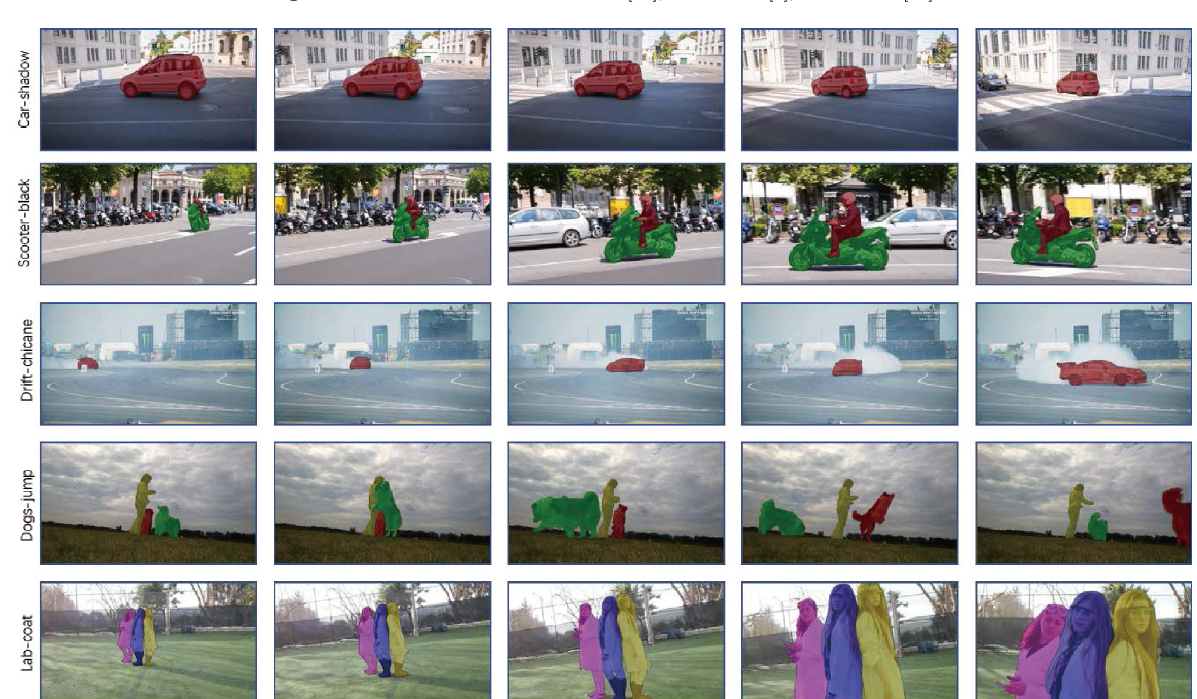
Fig. 9 Further results from our method using the DAVIS 2017 validation